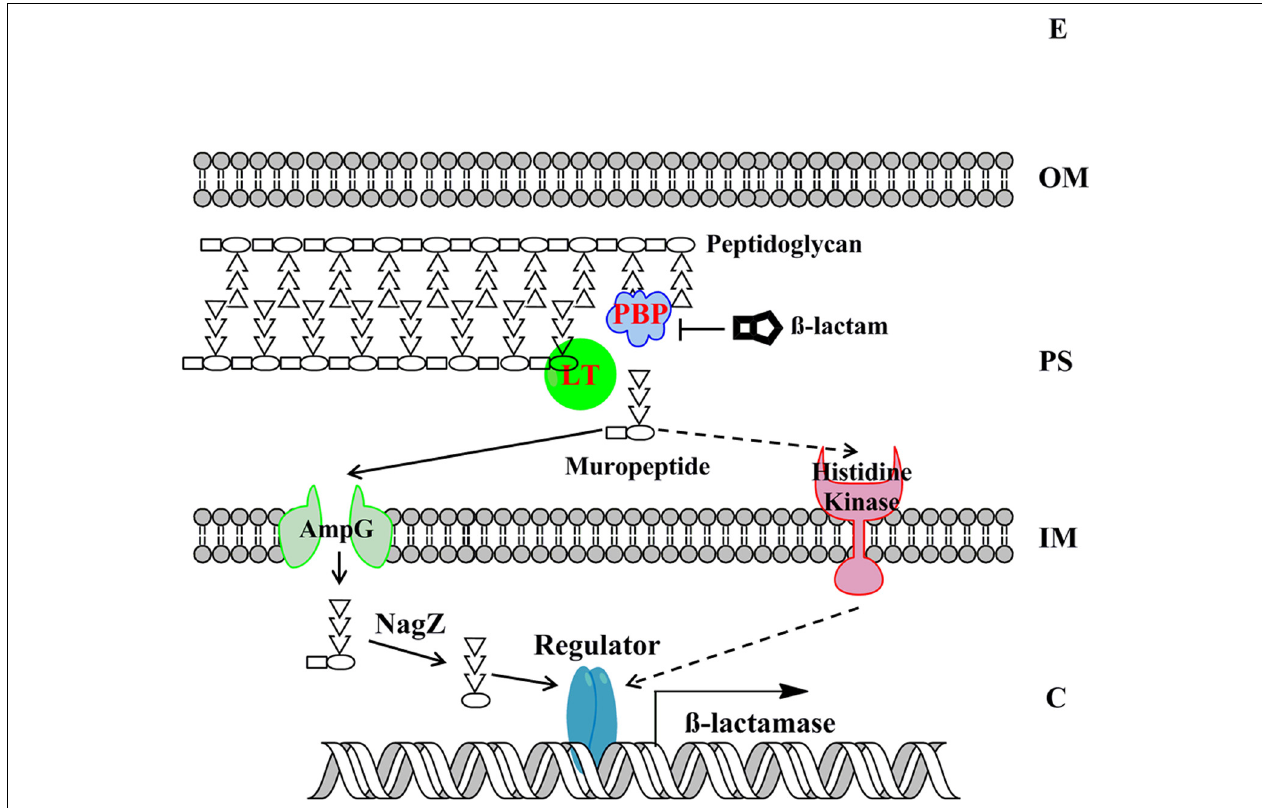
date and is shown in dashed arrows.The “Regulator” denotes AmpR-like regulator or two-component response regulator.The “beta-lactamase” denotes the beta-lactamase that is subjected to induction. E, extracellular environment; OM, outer membrane; PS, periplasmic space; IM, inner membrane; C,